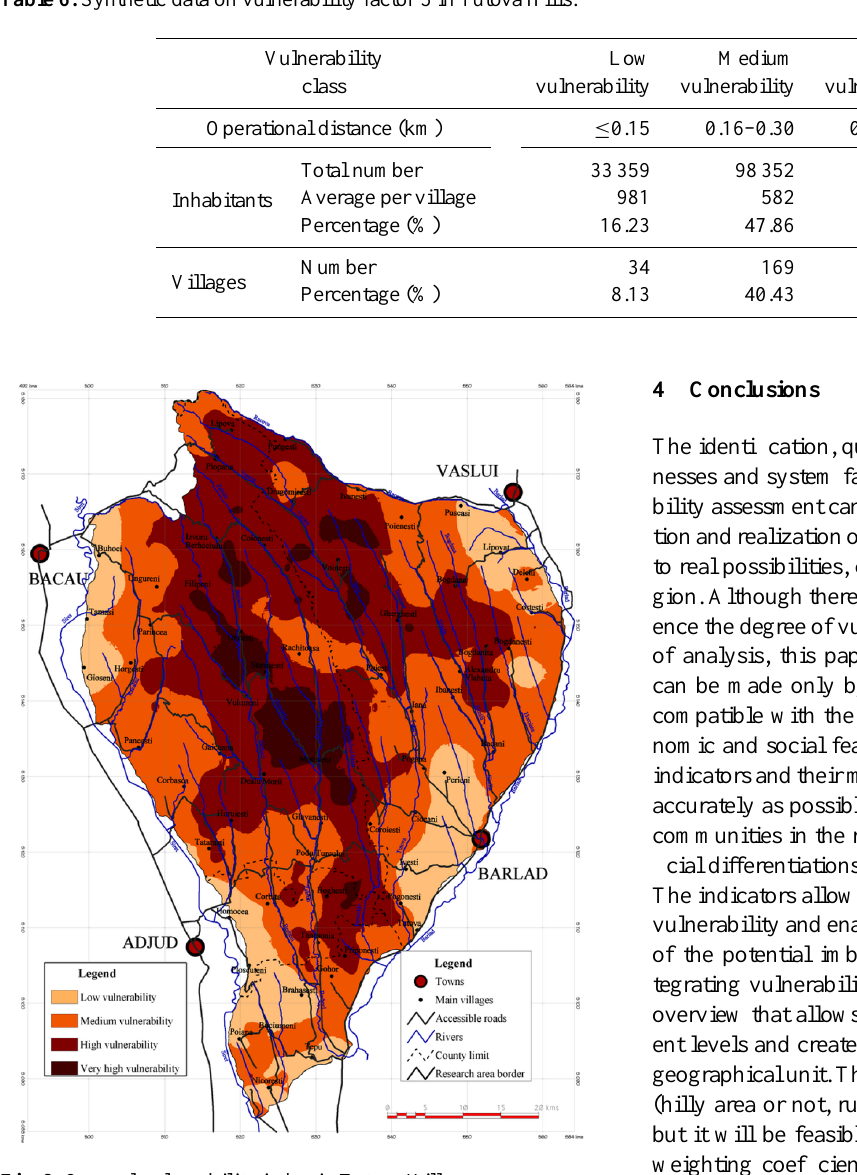
Fig. 8. General vulnerability index in Tutova